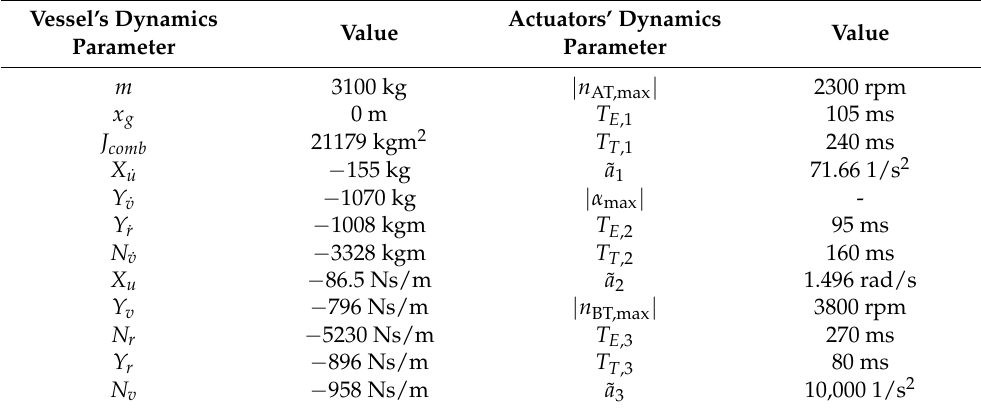
Table 1. Identified vessel parameters of the dynamic model [26] and the parameters of the actuators’ models [24].